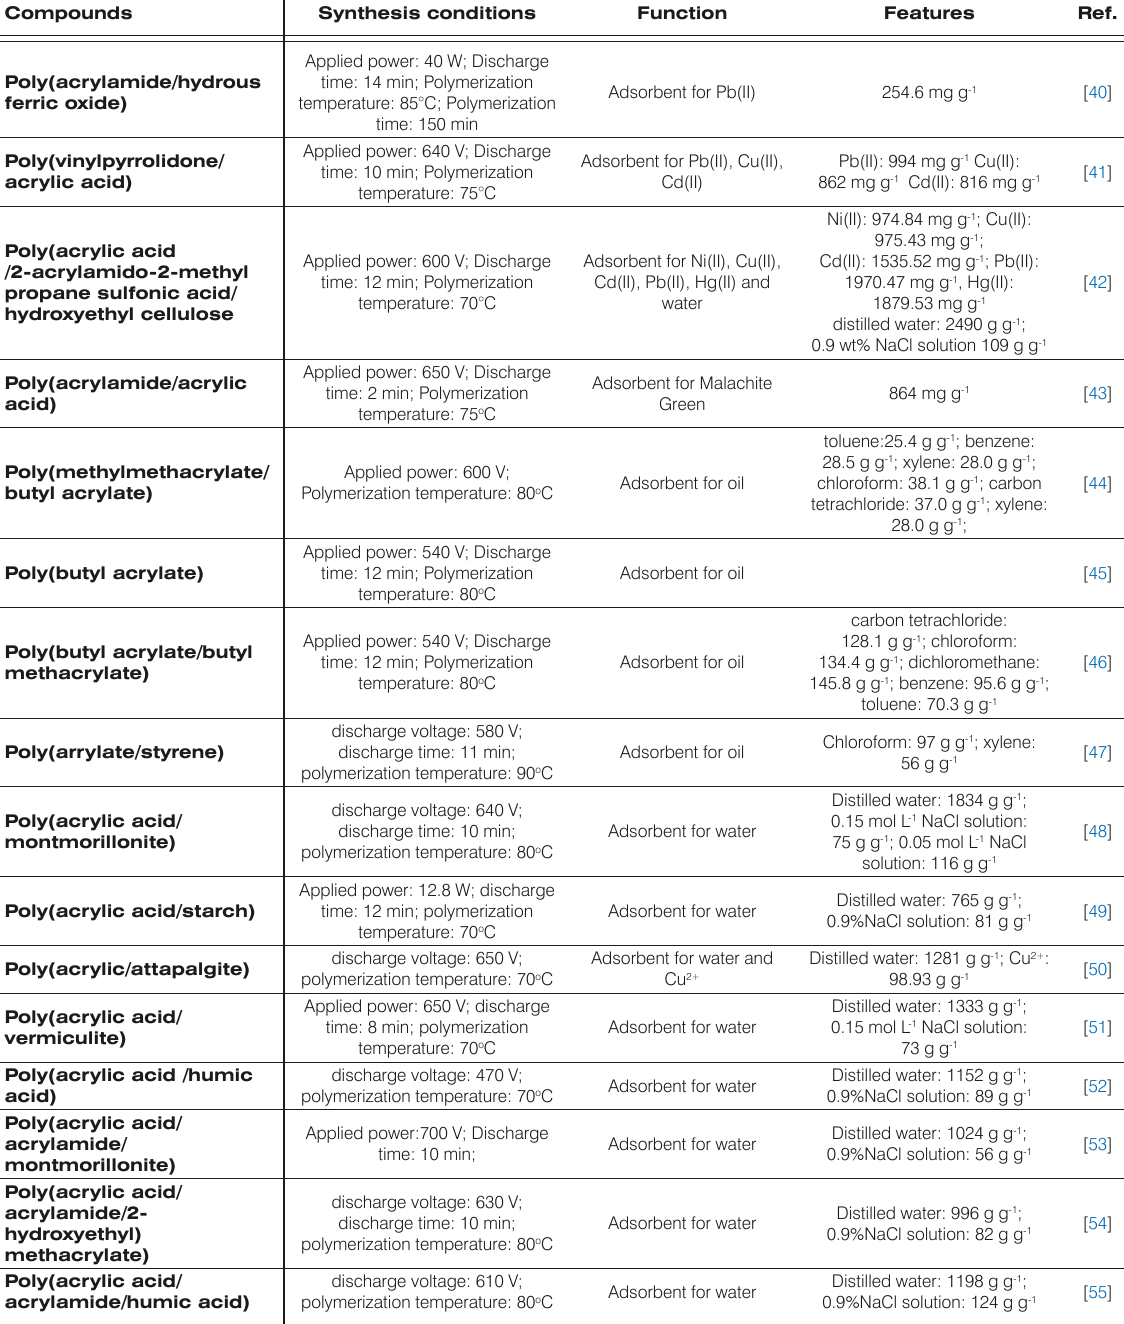
Table 4. Use of GDEP preparation functional materials. Compounds Synthesis conditions Function Features